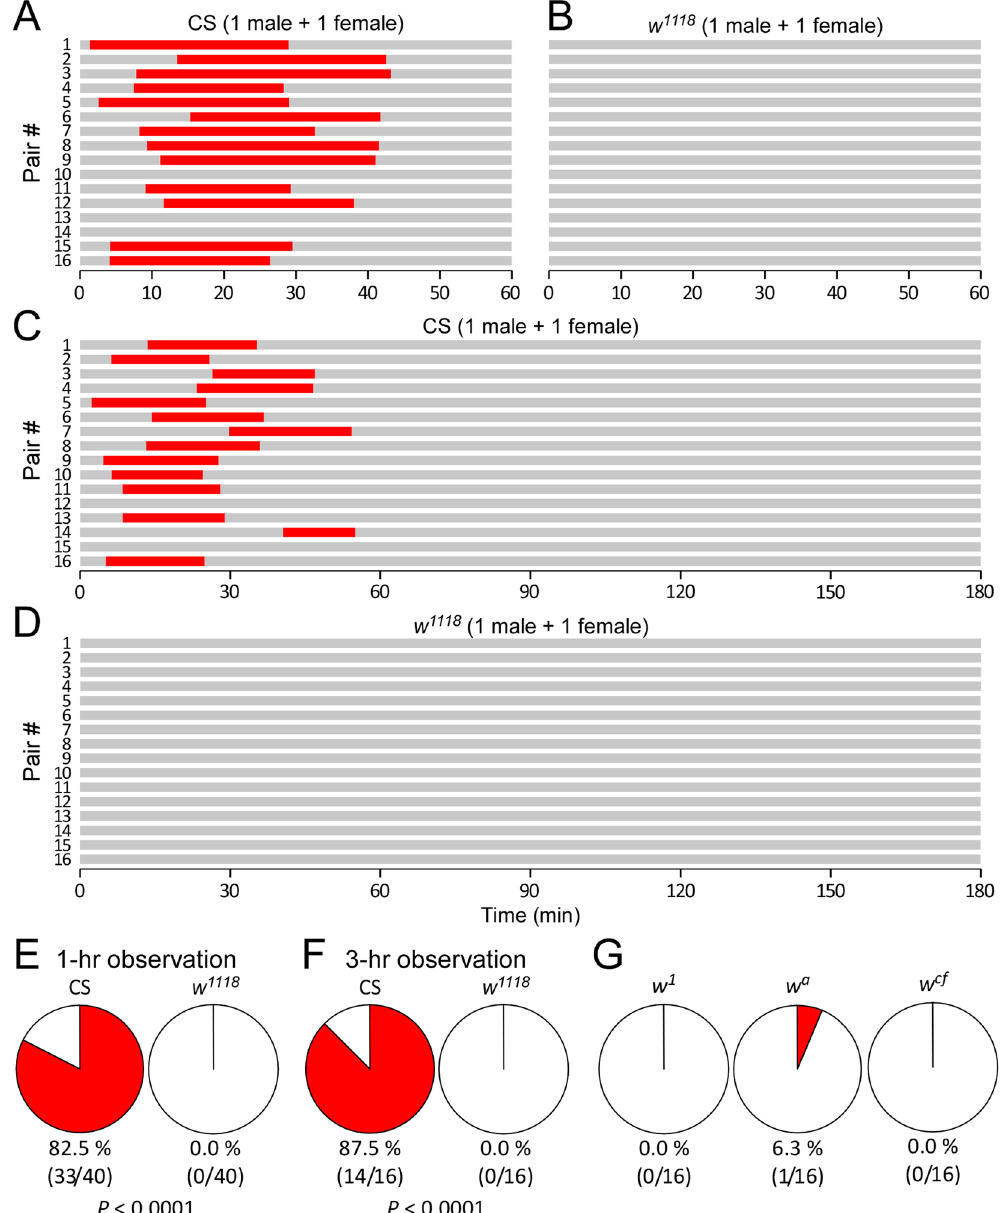
Figure 2. Reduced copulation success in w mutants. ( A , B ) Schematic illustrations of copulation success within 60 min in CS and w 1118 flies. The time for successful copulation (red) and non-copulation (grey) are indicated. ( C , D ) Copulation success within 180 minutes in CS and w 1118 flies. ( E ) Percentages of copulation success (red) during 1-hr observation in CS and w 1118 flies. ( F ) Percentages of copulation success during 3-hr observation in CS and w 1118 flies. ( G ) Percentages of copulation success in w 1 , w a and w cf mutants. Notes: The red piece in the pie chart indicates copulation success. A pair of flies comprise a naive male and a virgin female. Tested flies are at 4–7 days old. Numbers of pairs tested and pairs with successful copulation are shown. P values are from Fisher’s exact